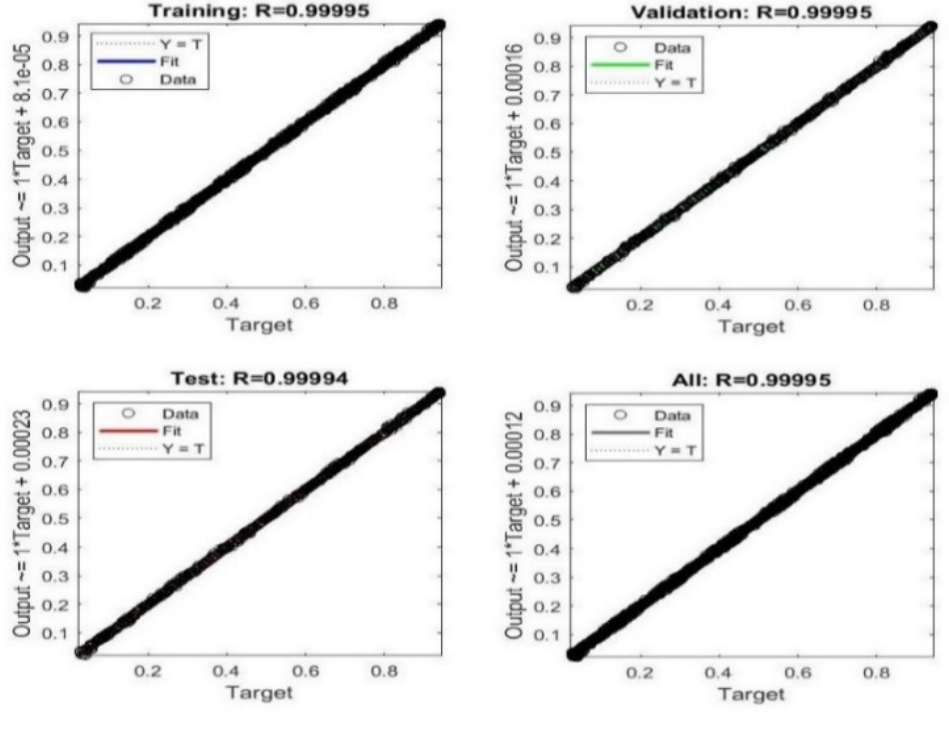
Figure 11. Regression results for NARX.